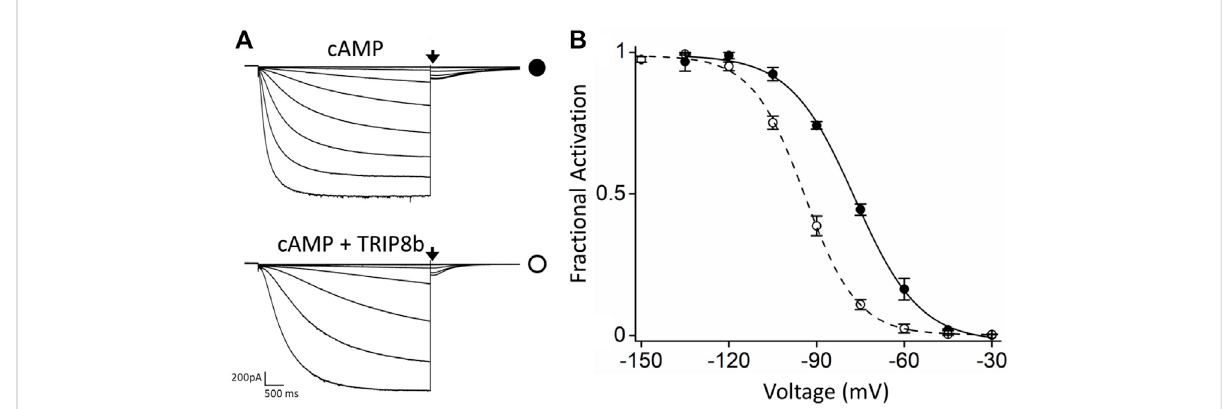
Functional characterization of the inhibitory effect of TRIP8b on the HCN4 construct employed for MP. (A) Representative whole-cell current traces of HCN4 channels recorded, with 0.25 µM cAMP in the patch pipette, in HEK293T cells transiently expressing the channel alone (top) or with GFP-TRIP8b(1a)(bottom).Blackarrowsindicatethecurrentselectedforanalysisin (B) . (B) MeanactivationcurvesofHCN4channelsalone(blackfull circles) or co-expressed with GFP-TRIP8b (1a) (black open circles) with cAMP in the patch pipette obtained from tail currents collected at − 40 mV (see arrows in panel (A) . Dashed lines indicate Boltzmann fi tting to the data (see Materials and methods) from which the half activation potential